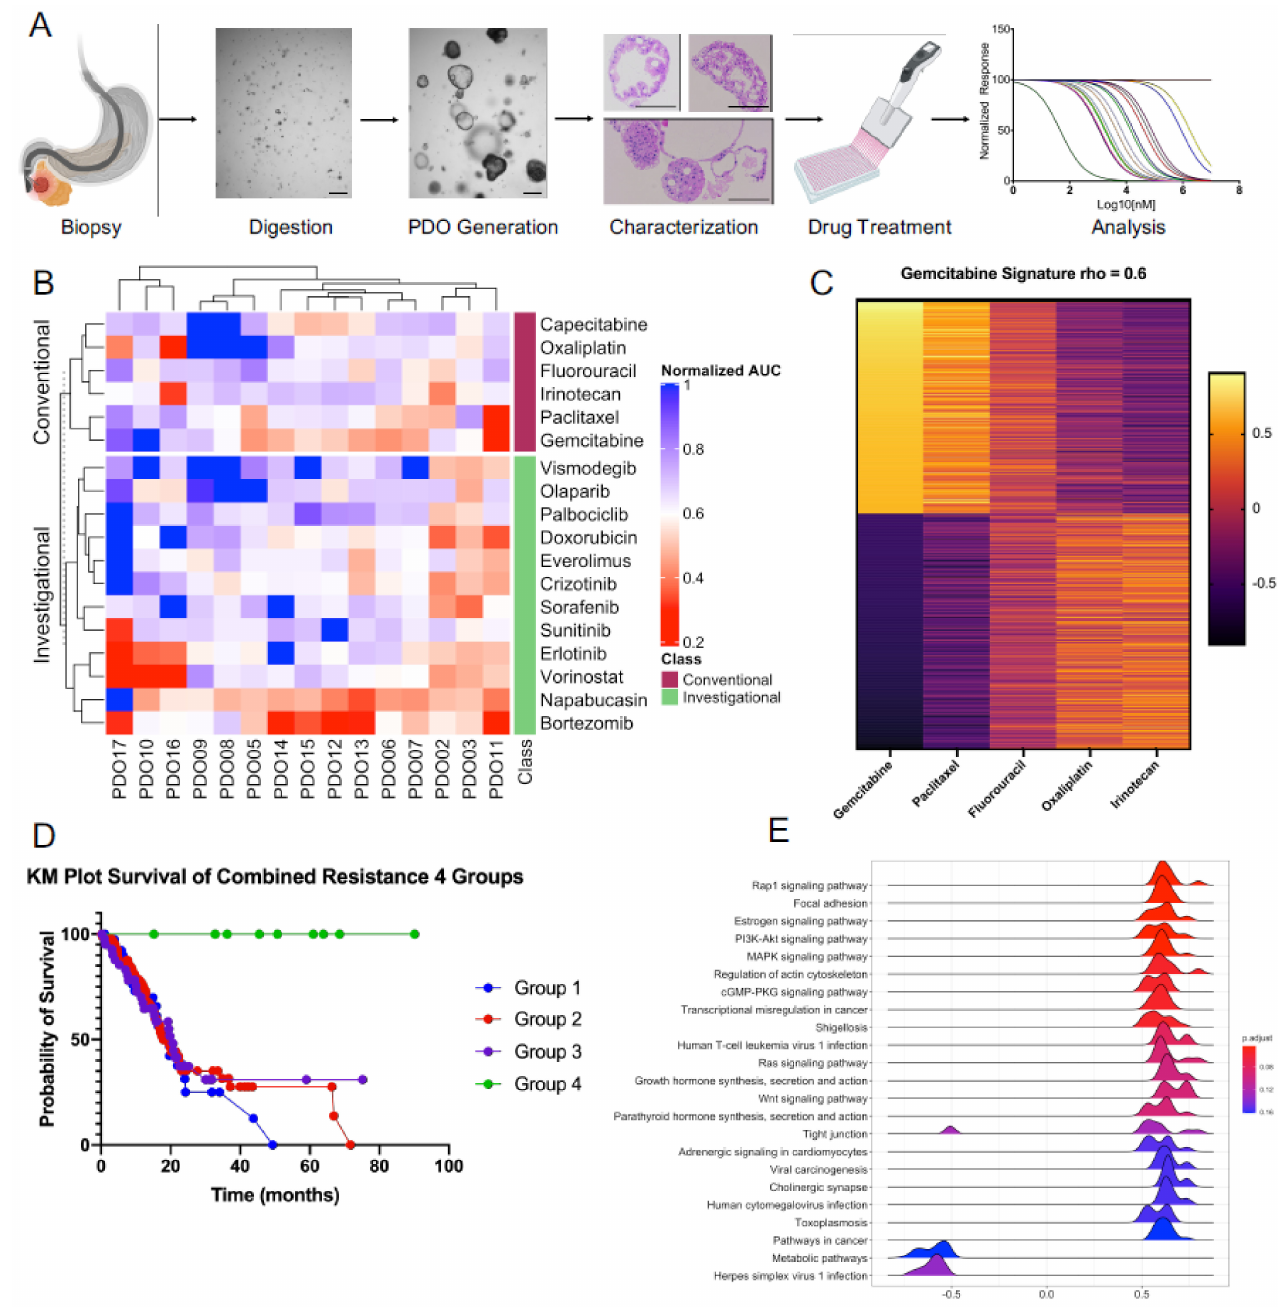
Figure 1. ( A ) Workflow describing the generation, characterization, and multiplex-drug screening assay of PDOs from EUS FNA biopsies (created with Biorender); scale bar 100 µ m ( B ) Heatmap of normalized area under the curve for all drugs. Analysis reveals heterogeneity in PDO response, both within individual drug treatments and within PDOs. Normalize area under the curve between 0 and 1 (Red—smaller AUC; drug sensitivity, Blue—AUC; drug resistance); ( C ) Heatmaps of highly correlated gene clusters specific to drug response. For each drug, genes were filtered to include only genes with Spearman rho values rho > |0.6| generating drug-specific gene profiles highly correlated with treatment response. Spearman rho values for each drug profile were then compared between all conventional drugs. Similarities in drug profiles indicate that similar gene expression is correlated with drug response; ( D ) Kaplan–Meier plot of PDA patients clustered by expression of combined resistance signatures. Clusters are ordered by expression 1–4, 1 being the highest and 4 is the lowest; ( E ) Ridge plot of KEGG pathways associated with response to Palbociclib treatment. Positively enriched pathways are associated with treatment sensitivity, and negatively enriched pathways are associated with treatment resistance. Pathway analysis was conducted using Gene Set Enrichment Analysis of KEGG pathways based on RNAseq gene